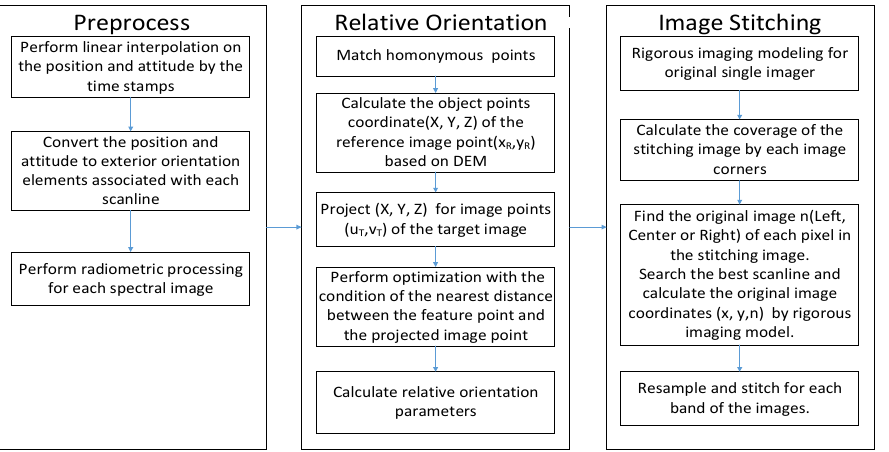
Figure 4. Workflow of imaging stitching.